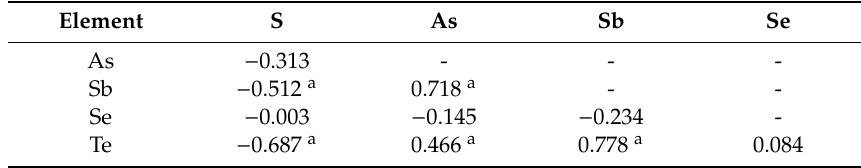
Table 4. Correlations among S, Se, Te, As and Sb in the Kueishantao native sulfur matrix.